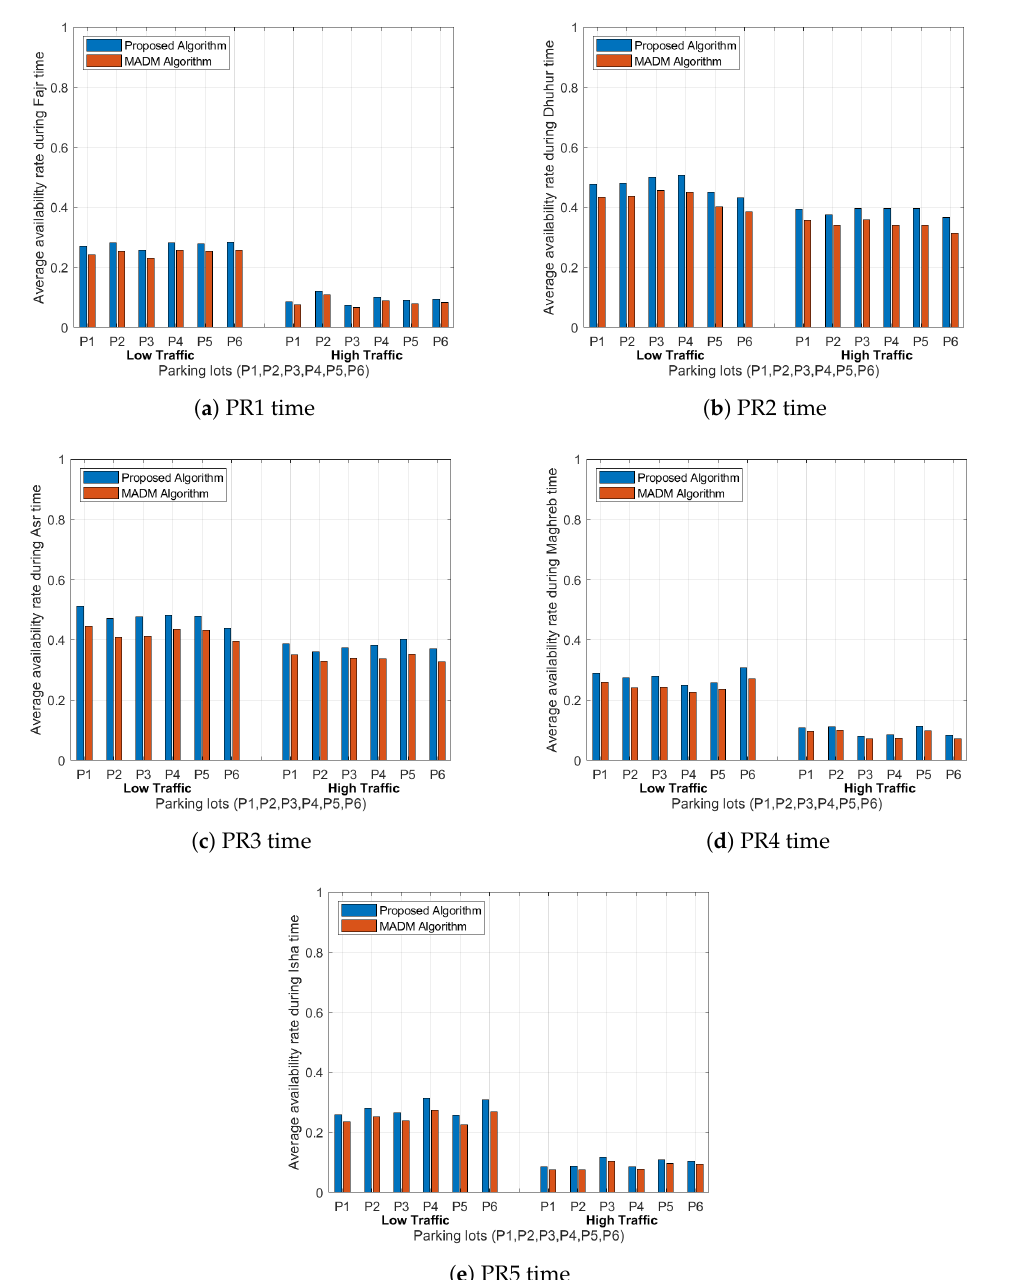
Figure 9. Average availability rates of the six parking lots (P1, P2, P3, P4, P5 and P6) for the five time periods (PR1–PR5) for both algorithms under low and high traffic